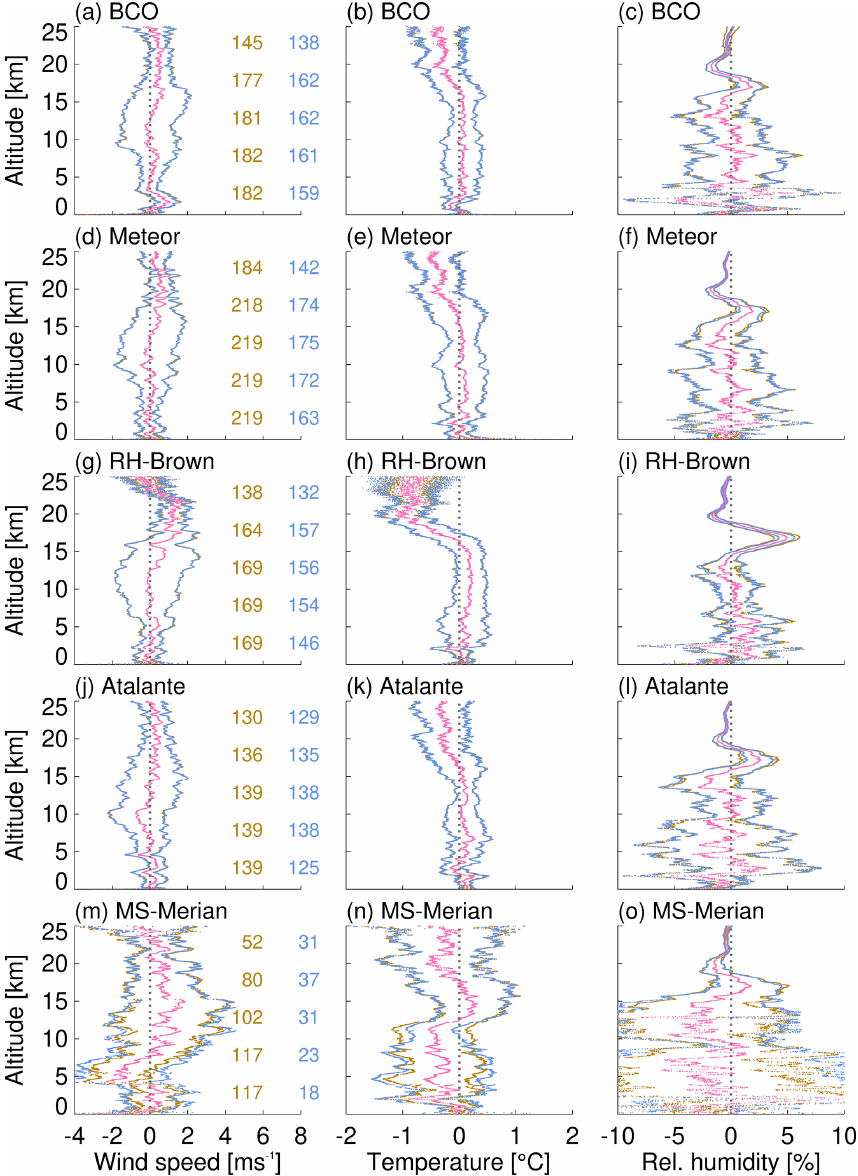
Figure 7. Comparison of (left) horizontal wind speed, (middle) air temperature, and (right) relative humidity, measured during ascent and descent. The pink dots show the average over all included ascent profiles minus the average over all included descent profiles. Brown (blue) dots show the 95% confidence intervals for ascent (descent). Numbers inside the panels on the left-hand side show the counts of ascending (brown) and descending (blue) radiosondes that crossed the corresponding height levels (2.5, 7.5, 12.5, 17.5, and